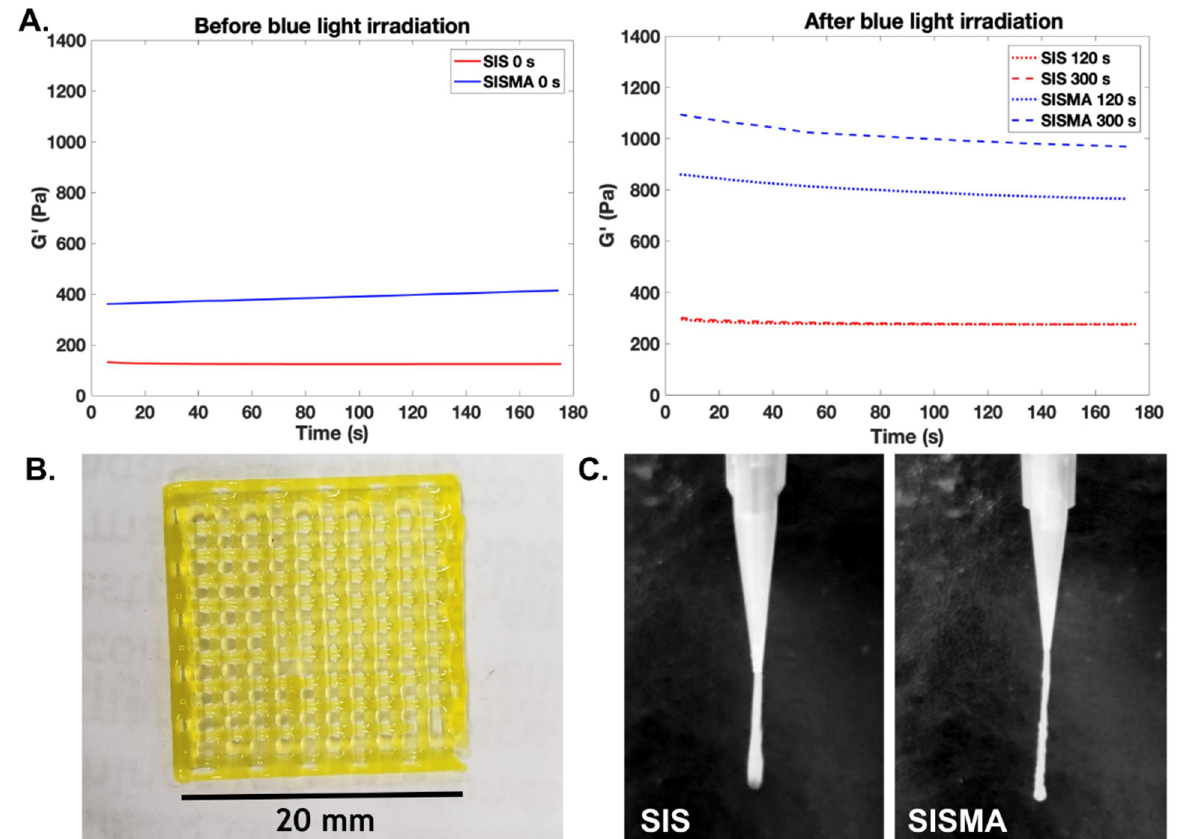
Figure 2. ( A ) Methacryloyl-modified small intestine submucosa dECM (SISMA) hydrogel bioprinted into a square lattice with high shape fidelity. ( B ) Filament formation of unmodified SIS and SISMA hydrogels made at the same ECM concen- tration (25 mg/mL) upon extrusion as a key feature for adequate printability. ( C ) Storage modulus of unmodified-SIS and SISMA hydrogels before and after photocrosslinking with varying exposure time. SISMA hydrogels exhibit superior me- chanical stability, before and after blue light irradiation, and superior crosslinking dynamics.